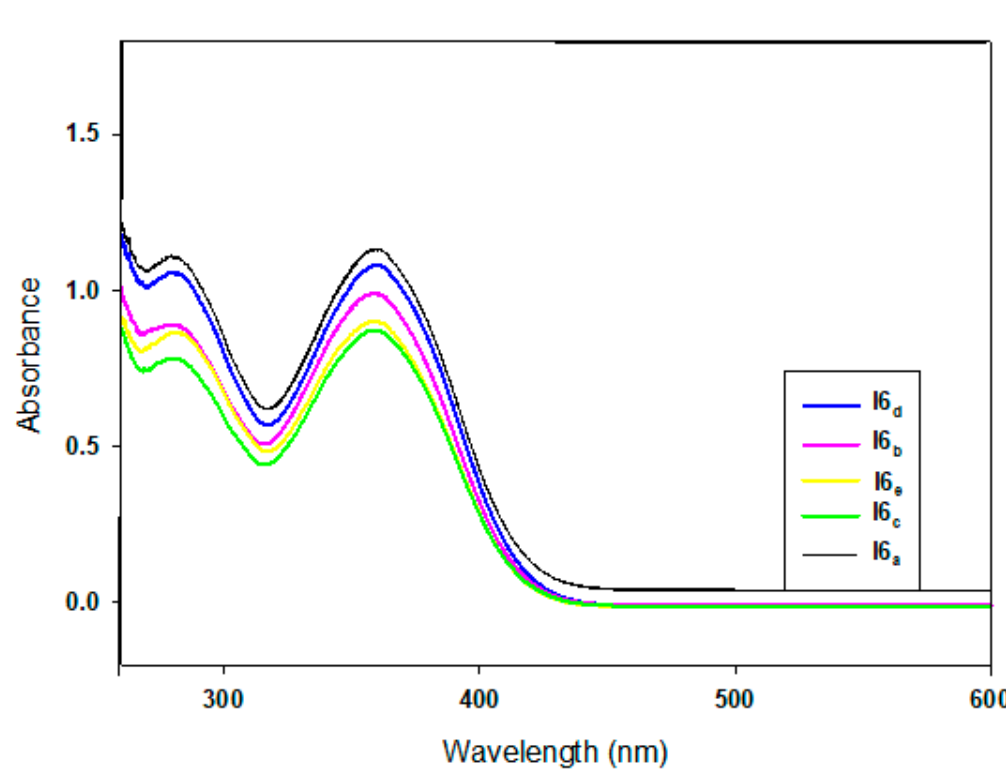
◦ a–e , in methylene chloride at 25